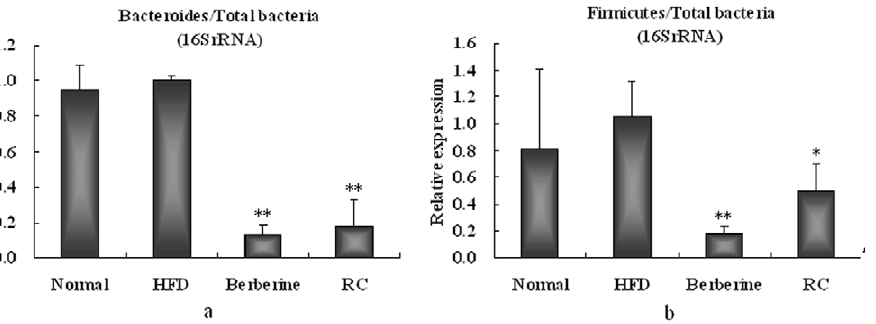
Figure 2. Effects of RC and berberine on 16SrRNA gene relative expressions of (a) Bacteroides/total bacteria and (b) Firmicutes/ total bacteria in feces of HFD mice. ‘‘Normal’’, normal chow diet-fed mice; ‘‘HFD’’, high-fat diet-fed control mice; ‘‘berberine’’, berberine-treated HFD mice; ‘‘RC’’, Rhizoma coptidis -treated HFD mice. Data were expressed as Mean 6 S.D. (n=6), * P , 0.05, ** P , 0.01 vs. HFD controls.